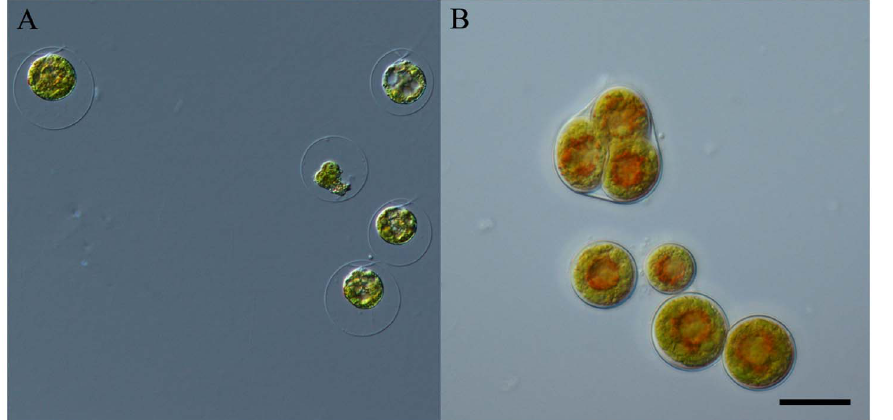
Figure 1. Microscopic observation of GV and OR cells. (A) GV cells were observed to be actively swimming in medium, making GV cells more competitive in cell proliferation and biomass accumulation. (B) OR cells lost the two flagellae and increased in size. The most striking feature of OR was the massive astaxanthin esters accumulated throughout the cells (red colour in OR was mostly from astaxanthin esters). bar=20 m m.